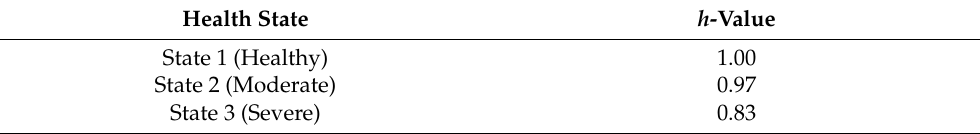
Table 1. The h -value based on the health